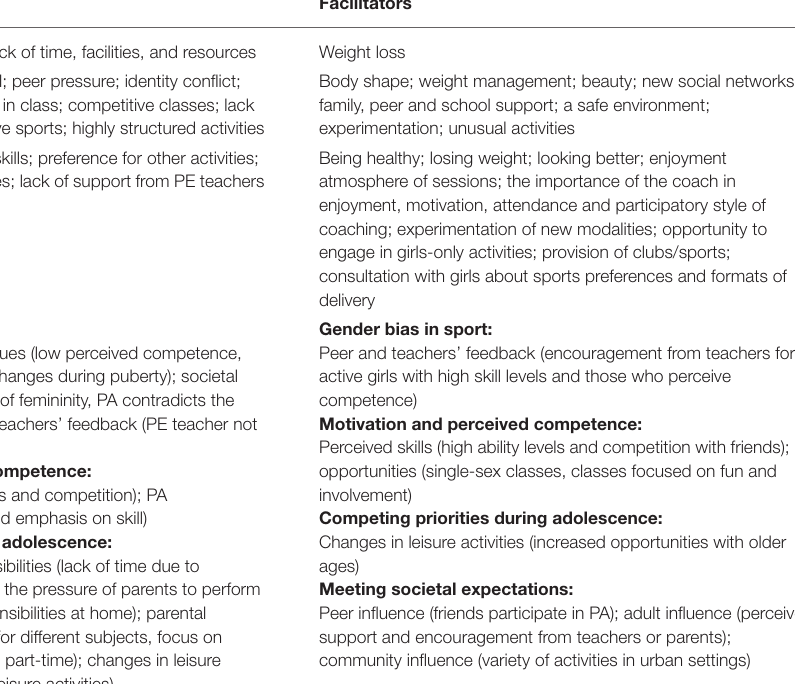
TABLE 3 | Barriers and facilitators identified in the selected systematic